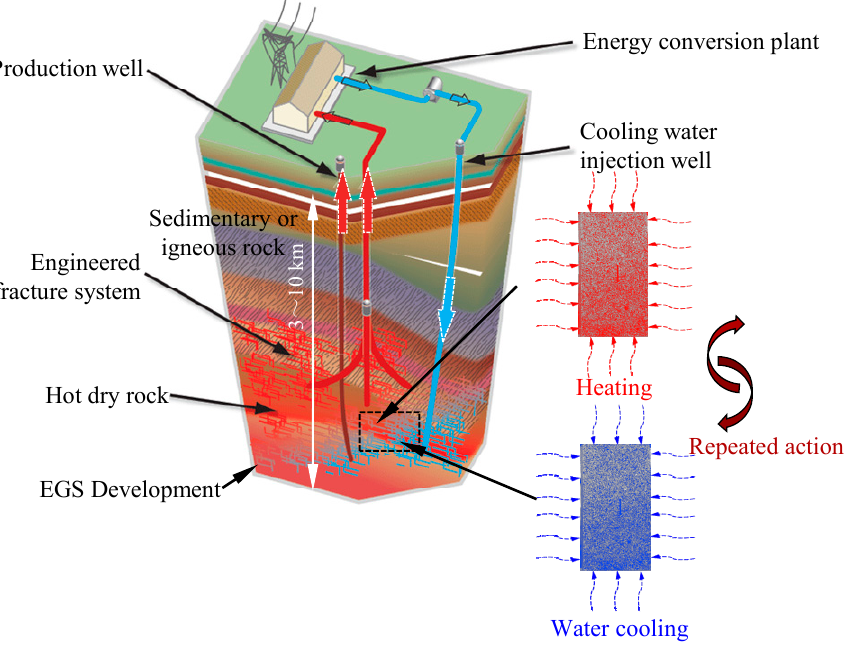
Figure 1. EGS mining model.